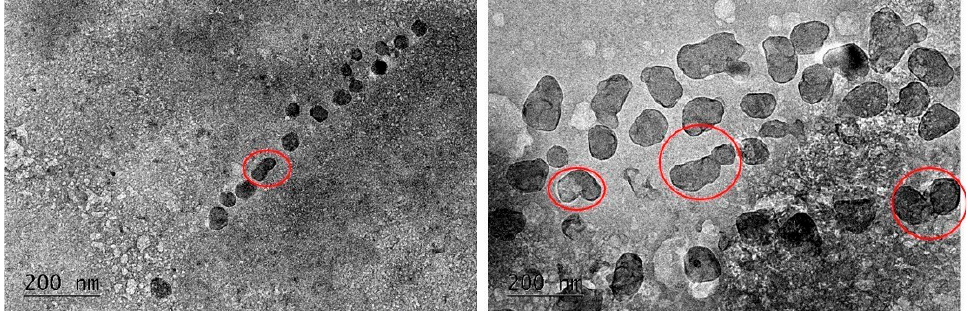
Figure 2. TEM images of GH-loaded chitosan/alginate NPs at different magnification.